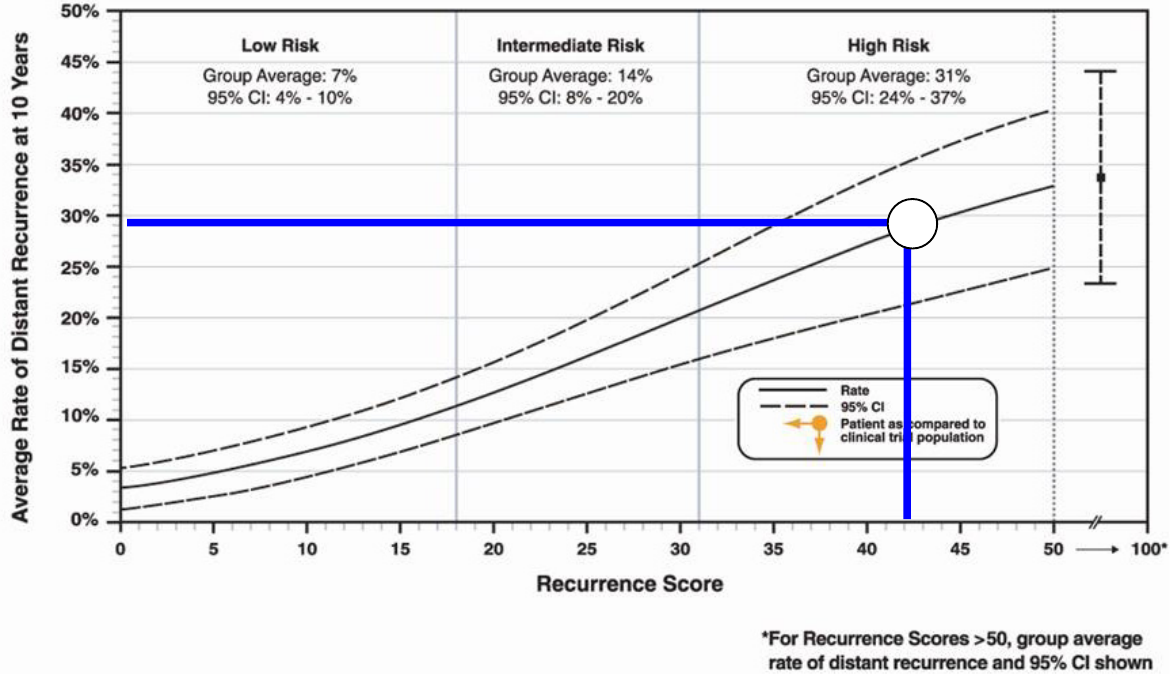
Figure 2. Risk of distant recurrence at 10 years based on genomic analysis with Oncotype DX. Patient recurrence score =